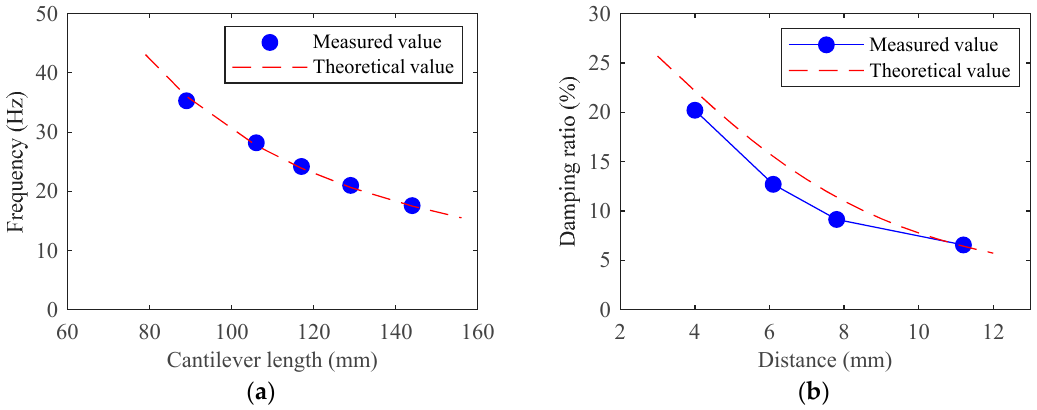
Figure 6. Dynamic characteristics of ECTMD. ( a ) ECTMD frequency varying with cantilever length; ( b ) Damping ratio varying with distance between copper plate center and magnet surface at ECTMD frequency of 24 Hz.